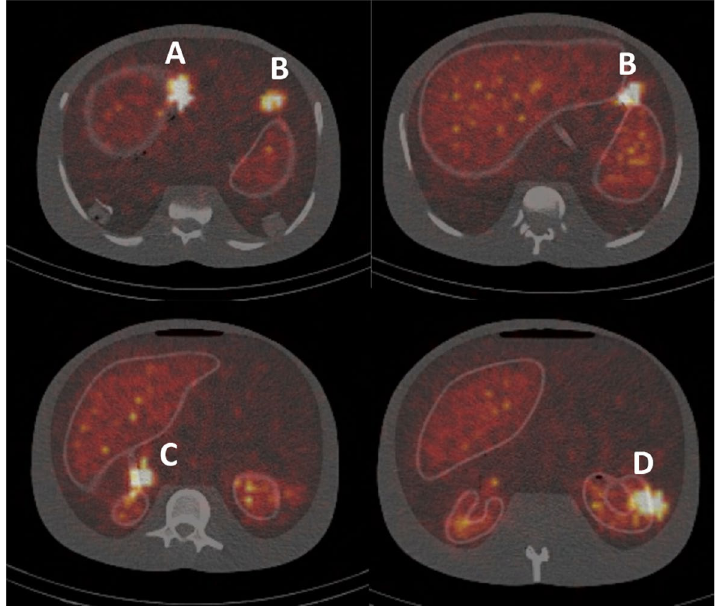
Fig. 9 Transaxial images of the anthropomorphic phantom indicating the locations of the point